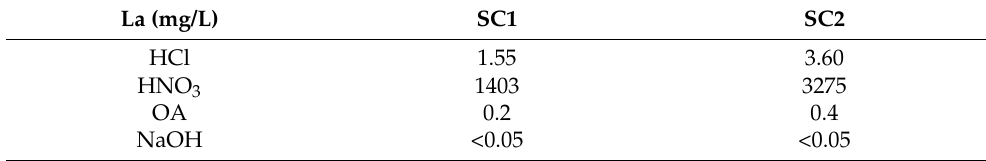
Table 2. Lanthanum concentration in the leaching solutions for both spent FCC powders.